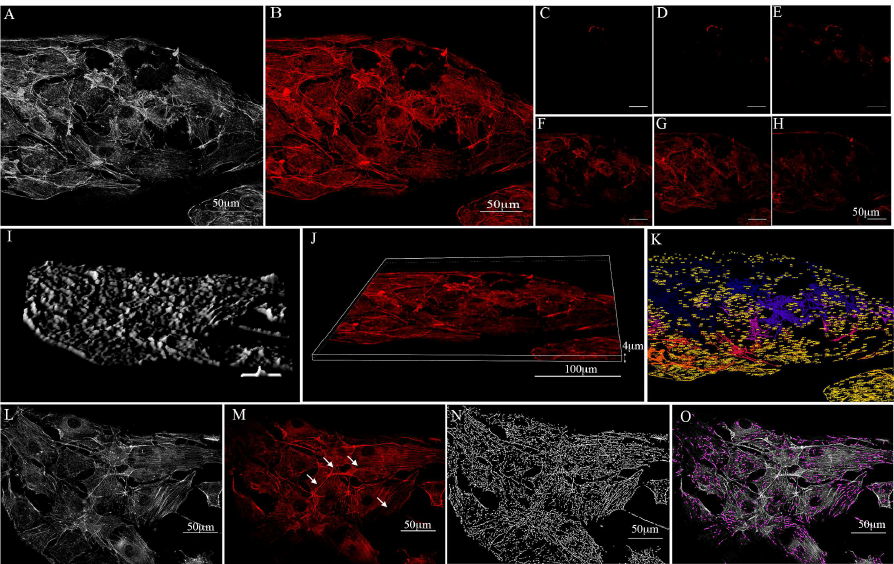
Figure 8. Preosteoblast growth over the poly(ε-caprolactone) (PCL) compounded with beta-tricalcium phosphate 20% (PCL+β-TCP 20%)-based substrate which was stained with phalloidin (TRITC-conjugate) for F-actin detection. ( A ) Map of the minimum of n nearest neighbour cells on the compound. ( B ) Confocal microscopy captured the preosteoblast actin filaments spreading on the surface of the substrate. ( C – H ) Confocal microscopy 3D illustration of the phalloidin-labelled F-actin of preosteoblasts over the substrate. Note the F-actin distribution over the substrate in multiple scans. ( I , J ) 3D surface plot of the substrate. ( K ) Projections of cell maps on the biomaterial. The numbers in yellow represent the pixel distances between the cultured cells and the substrate. ( L ) A map of proximal neighbour preosteoblasts on the substrate meshes. Note the actin adhesion points (white arrows) between the cells ( M ) and the actin filament skeleton in expansion on the substrate ( N ). ( O ) Filopodium formation is tagged with a purple colour. The open-source image processing software ImageJ [version ImageJ2 2.9.0/1.53t] was used for image analysis [47].